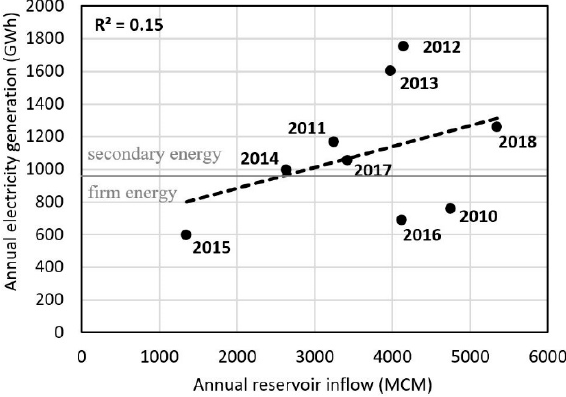
Figure 14. Correlation between annual reservoir inflow and annual energy production.